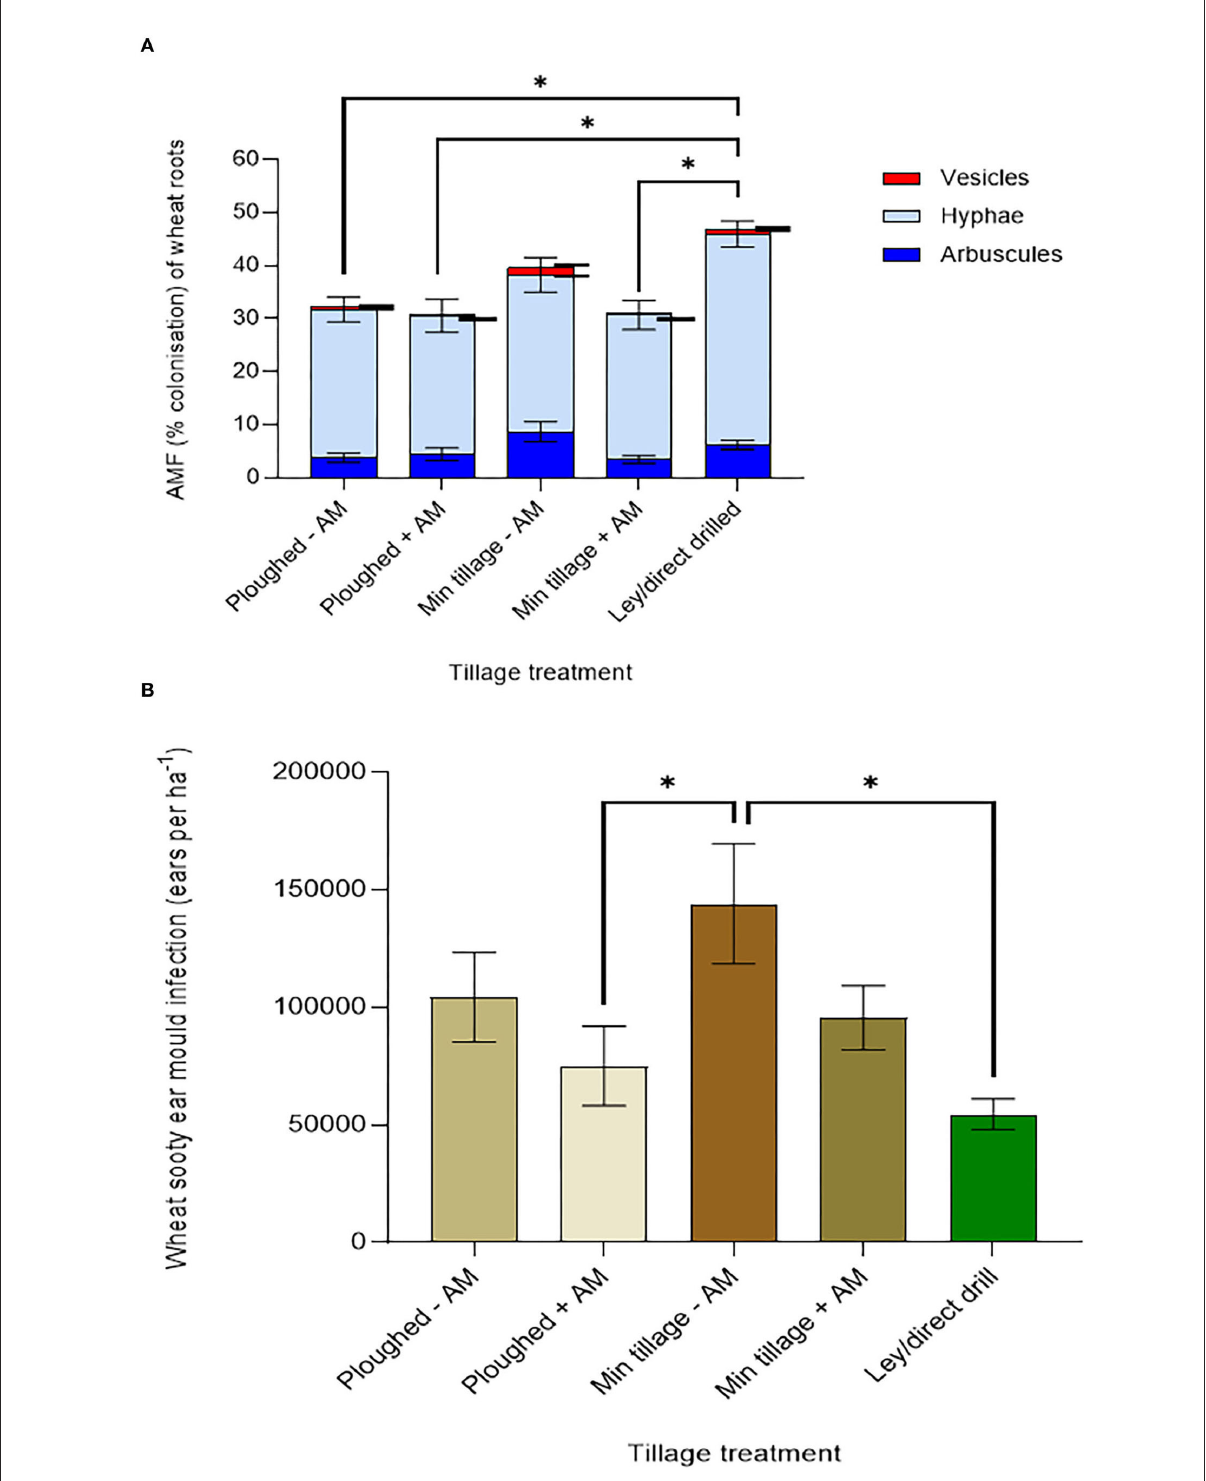
FIGURE5 Wheat performance, averaging across genotypes, on ploughed and minimally tilled plots, with added sterile carrier (- AM) or commercial AMF inoculum ( + AM) compared to direct drilling into a 3-year ley at the 2018 harvest. (A) Mycorrhizal abundance (% colonisation of wheat roots by hyphae, arbuscules, and vesicles) (ploughed and disc cultivated n = 24, ley n = 14), and (B) Sooty ear mould (infected ears ha − 1 ) ( n = 24 in all treatments). The error bars show ± 1 SE. Results of significant Tukey’s HSD test results of significant differences are shown on the graphs (* p = 0.05; ** p = 0.001; *** p < 0.0001